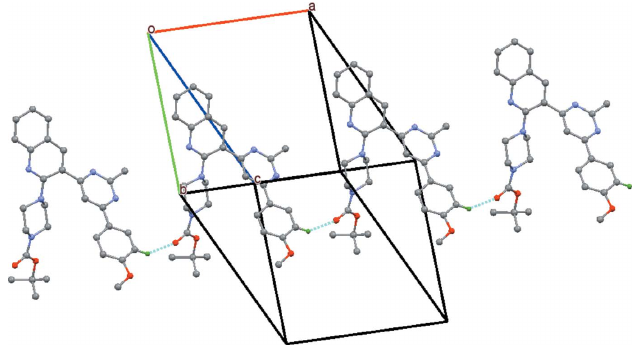
Figure 3 Partial packing plot. Dashed lines indicate the C—H (cid:3)(cid:3)(cid:3) O intermolecular interactions forming chains along [100]. H atoms not involved in these interactions have been omitted for clarity.